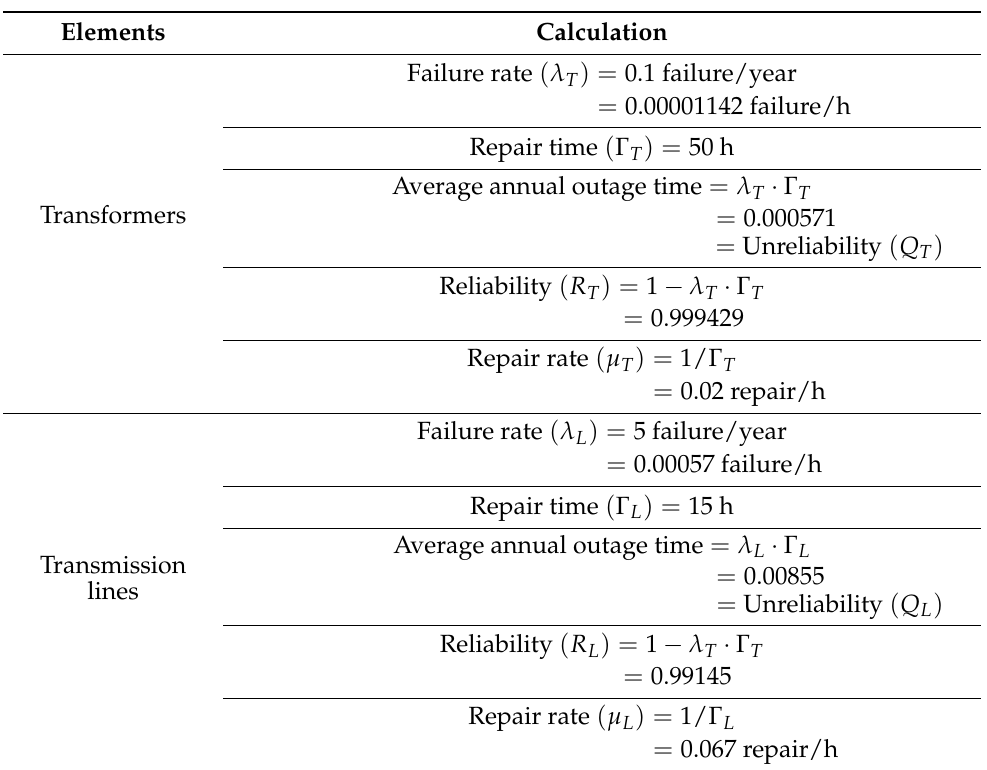
Table 3. Calculation of parametes for reliability